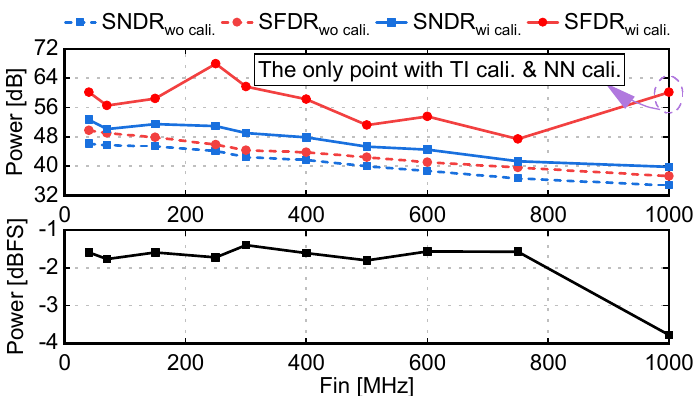
Figure 14. Measured dynamic performance versus input frequency @ 2.5 GS/s and associated input power. (The performance for the 1-GHz input frequency is further calibrated with a NNC, other measurements are based on interleaved mismatches calibration only including Figure